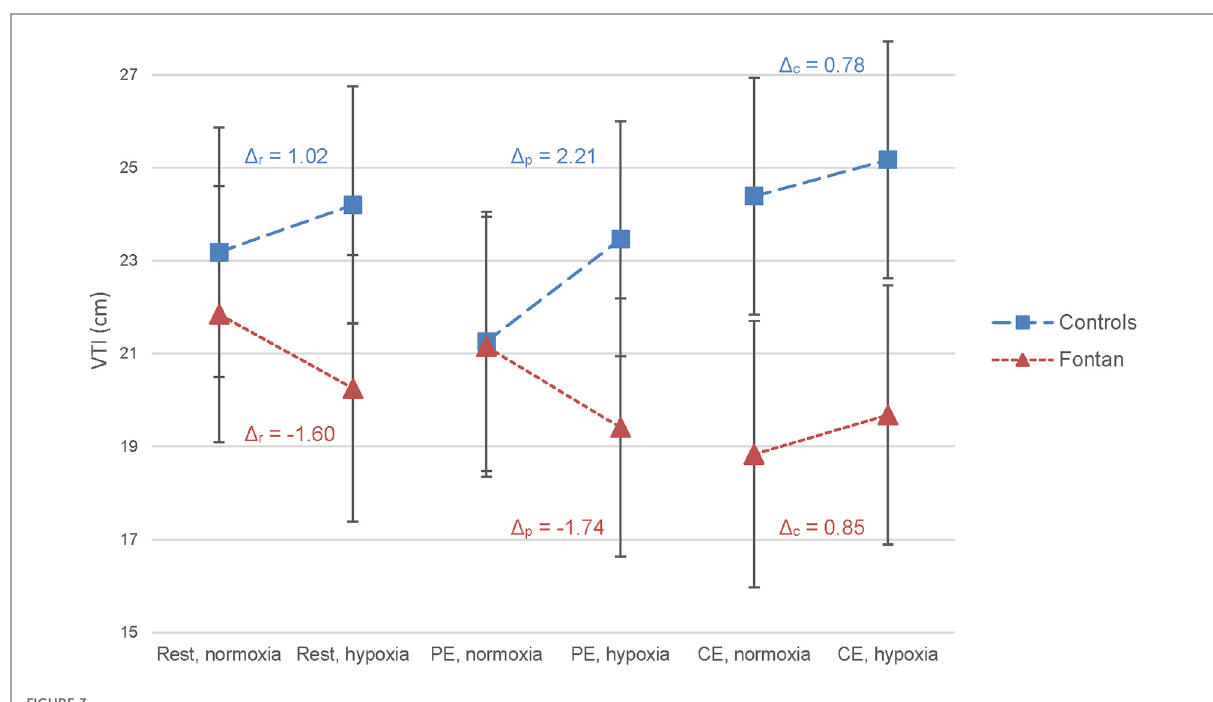
FIGURE 3 Effect of exercise and hypoxia on velocity time integral (VTI) in Fontan patients and controls analyzed by LMM. No statistically signi fi cant effects of exercise or hypoxia on VTI were found in either group. Δ =(mean predicted VTI in hypoxia – mean predicted VTI in normoxia) in cm; calculated for each exercise level and